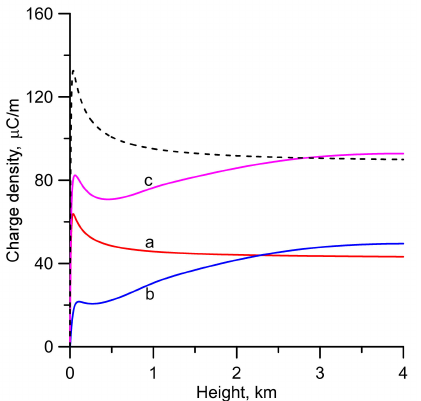
Figure 14. The charge deposited by the incident current (curve a) and by the reflected current (curve b). The total charge deposited by both incident and reflected currents is given by curve c. For comparison purposes, the charge deposited by the incident current in the absence of a current reflection is shown by the dashed line. Note that the total current at ground level with or without the current reflection is equal to 12